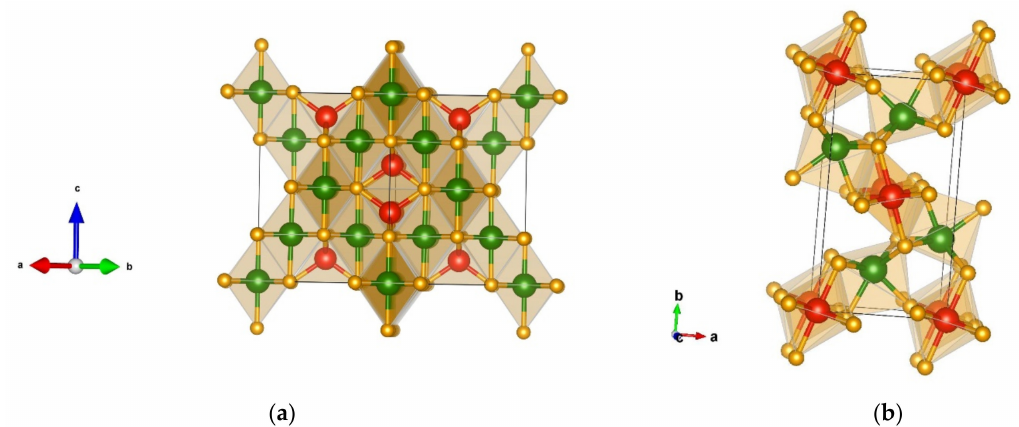
Figure 5. Visualization of favorable Cr2SiN4 modifications: ( a ) Al2MgO4-spinel-type in space group Fd-3m (no. 227); ( b ) Na 2 MnCl 4 -type that appears in space group Pbam (no. 55). Green, red, and yellow spheres denote Cr, Si, and N atoms, respectively.